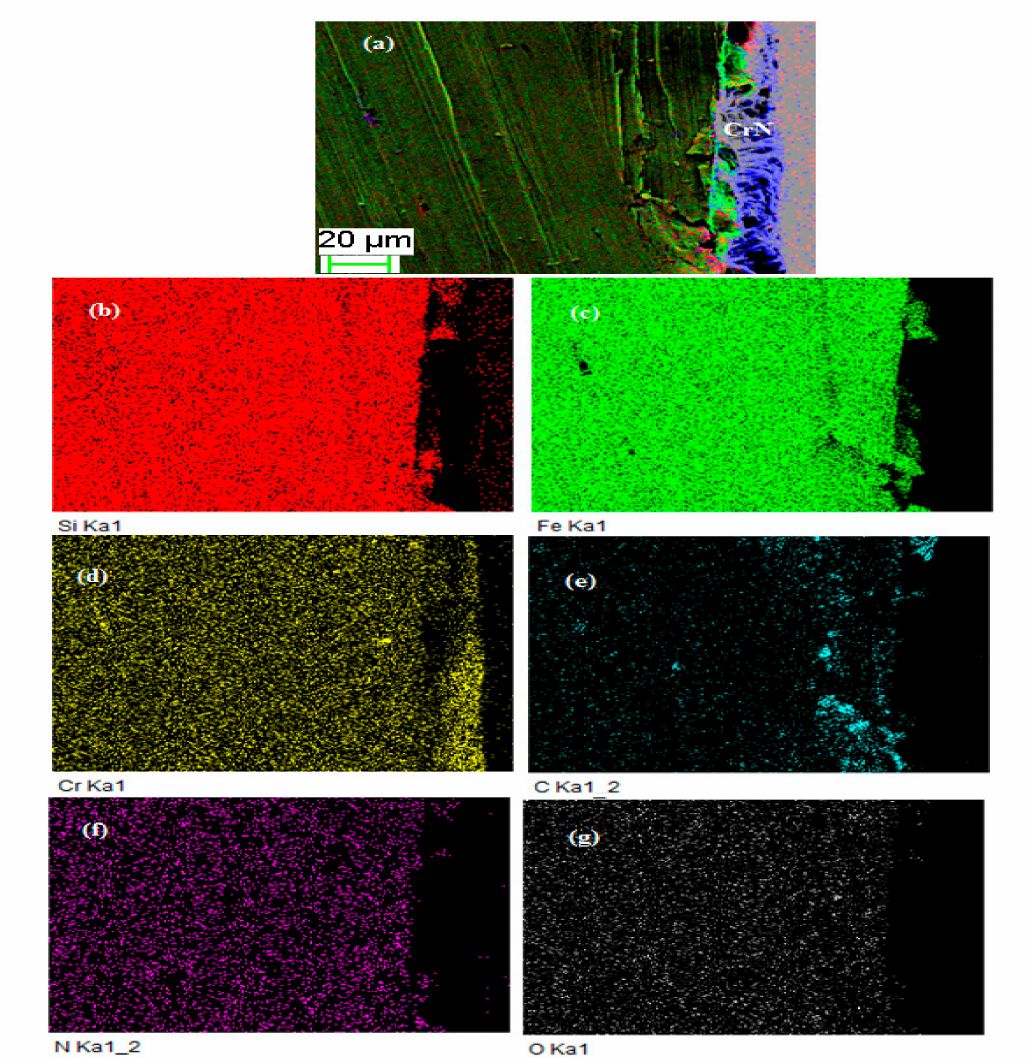
Figure 5. Cross-section mapping results of CrN coating as deposited: ( a ) cross-section scanned position, ( b ) Si content, ( c ) Fe content, ( d ) Cr Content, ( e ) C content, ( f ) N content, ( g ) O